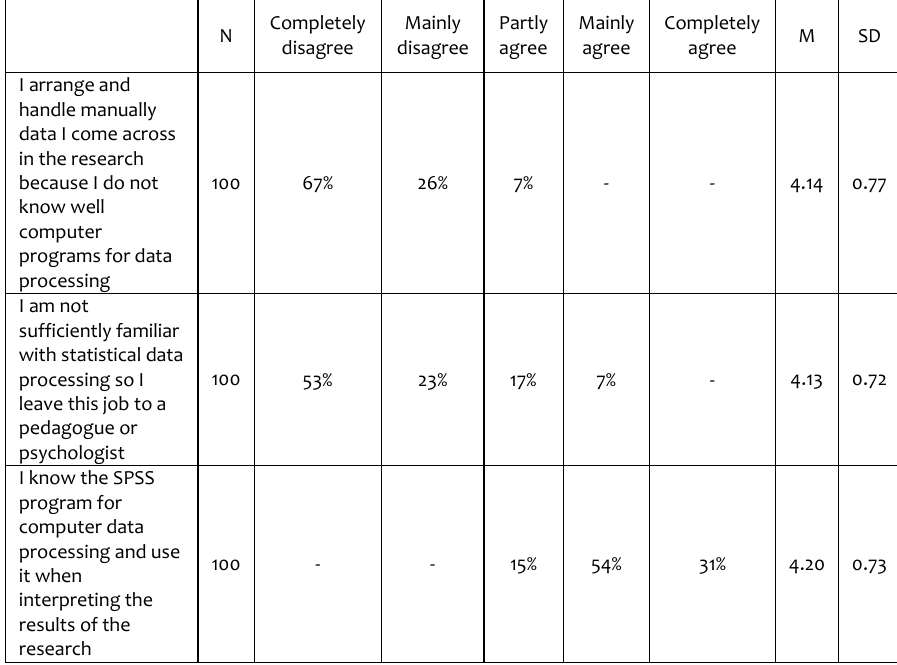
Table 4: Teachers' statistical